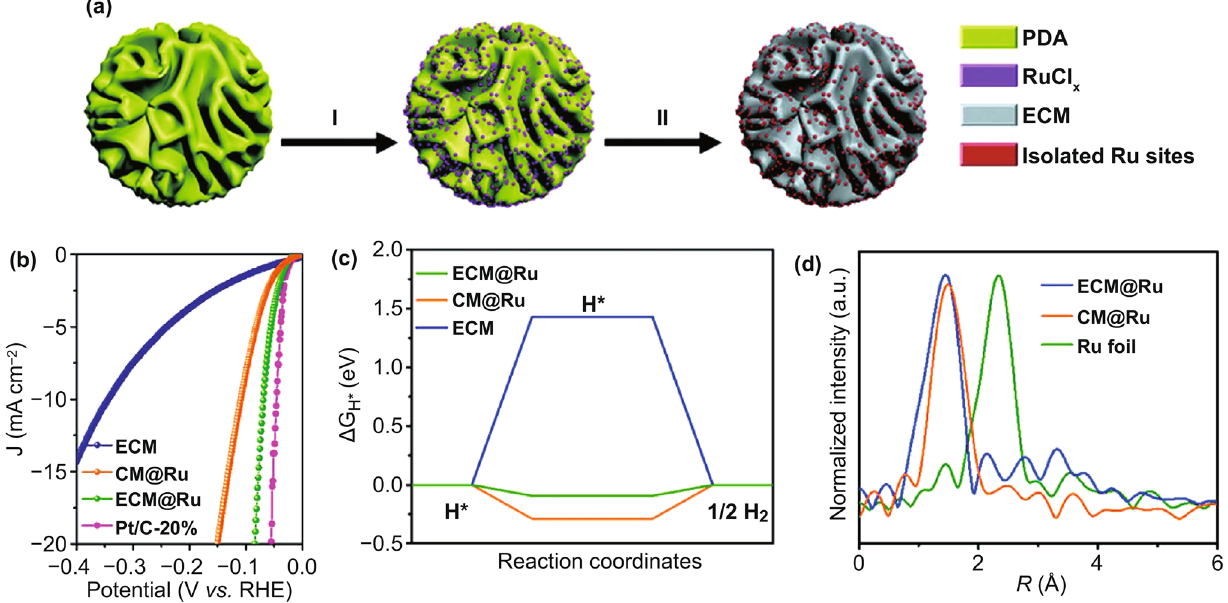
Fig. 8 a Schematic illustration of the synthetic procedure of ECM@Ru. b Polarization curve of ECM@Ru at 0.5 M H 2 SO 4 . c Calculated ΔG H* on ECM@Ru, CM@Ru, and ECM. d Fourier-transformed magnitudes of the experimental Ru K-edge EXAFS spectra [97], with permission from the Wiley–VCH Verlag GmbH & Co. KGaA,